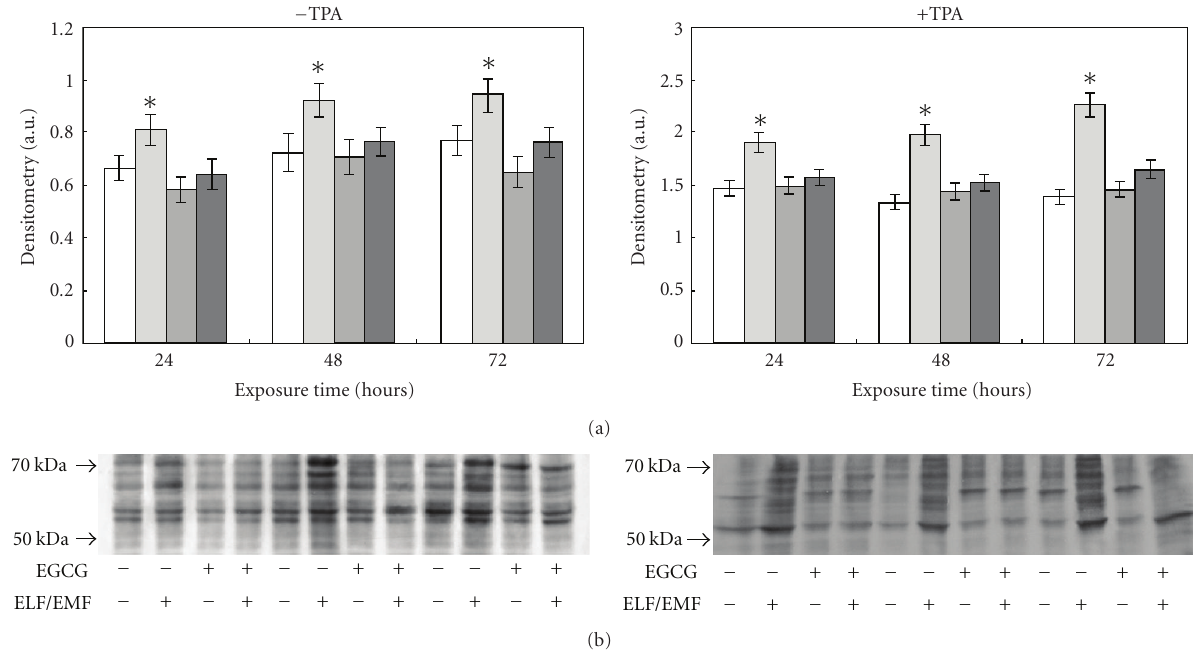
Figure 4: E ff ect of ELF-EMFs exposure and EGCG treatment on protein oxidation. Protein oxidation was analysed and quantified by measuring the amount of protein carbonyl groups. The densitometric analysis from six separate blots provided for quantitative analysis of the amount of protein carbonyls is present (panel A) and a representative Western blot of protein carbonyls is shown (panel B). Equal protein loading was verified by using an antibody directed against GAPDH (panel C). Caco cells were cultured with and without 150 μ M EGCG, with and without TPA and exposed to ELM-EMFs for 24, 48 and 72 hours. After harvesting and lysing the cells, samples were treated according to the OxyBlot procedure (Oxidized Protein Detection Kit, Oncor). Carbonyl groups were revealed by appropriate antibodies using an Enhanced ChemiLuminescence Western blotting analysis system. Data points marked with an asterisk are statistically significant compared to their respective not exposed control cells ( P < .